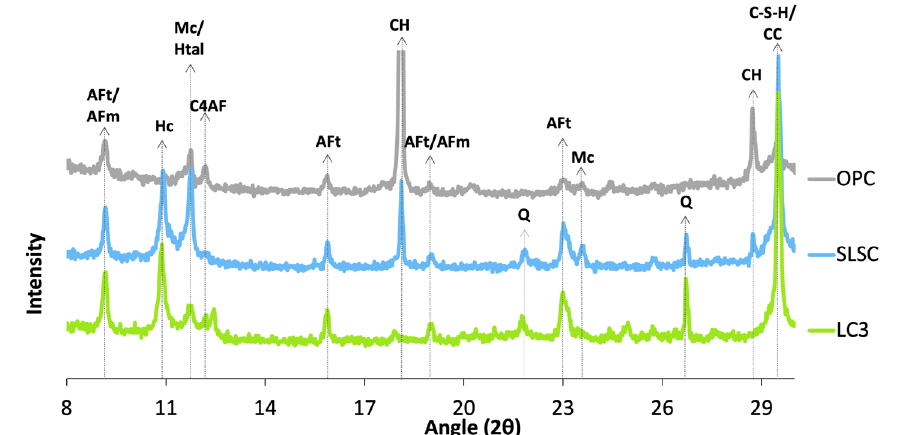
Figure 6. Evolution of hydration products observed using XRD on the 90 day hydrated samples of OPC, LC 3 and